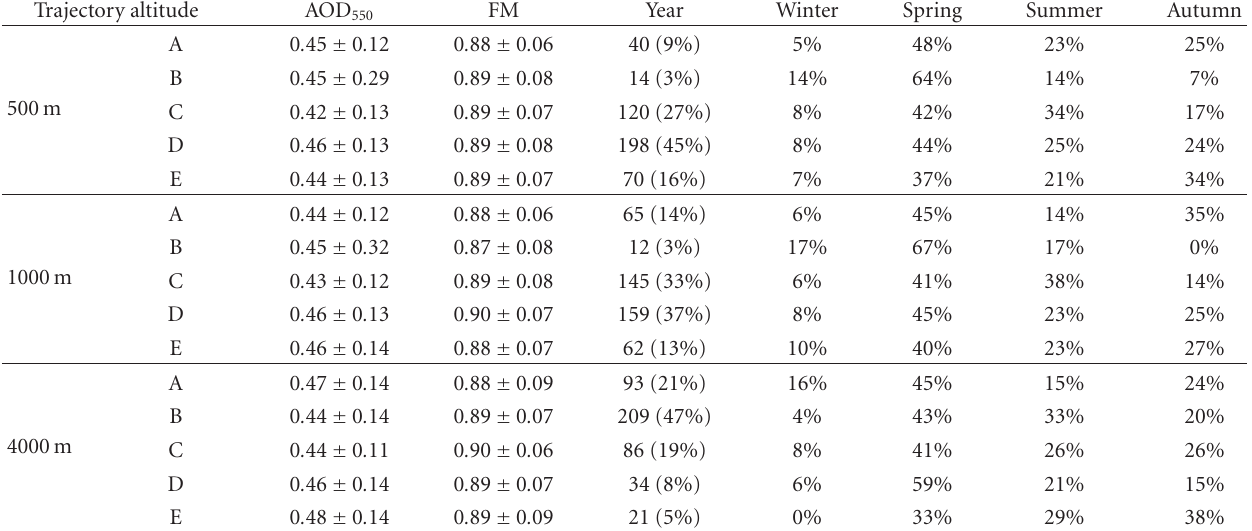
Table 2: As in Table 1, but for the UI